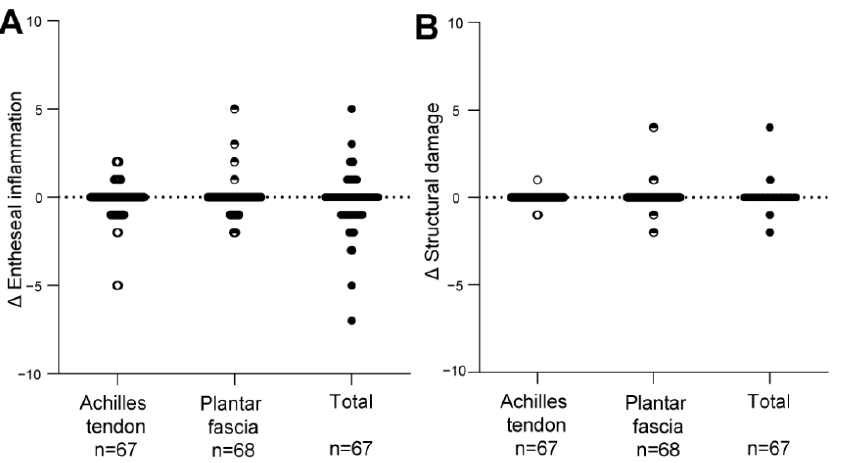
Figure 1. Change in HEMRIS Entheseal inflammation and HEMRIS Structural damage after lon- gitudinal follow-up. After one-year follow up intervals, no significant changes were observed in ( A ) HEMRIS Entheseal inflammation, and ( B ) HEMRIS structural damage. Data are presented as the median change and individual values of change in HEMRIS (Delta HEMRIS). HEMRIS scores of both ankles were summated. Figure Legend: Abbreviations: ∆ = delta, HEMRIS = Heel Enthesitis Scoring System.